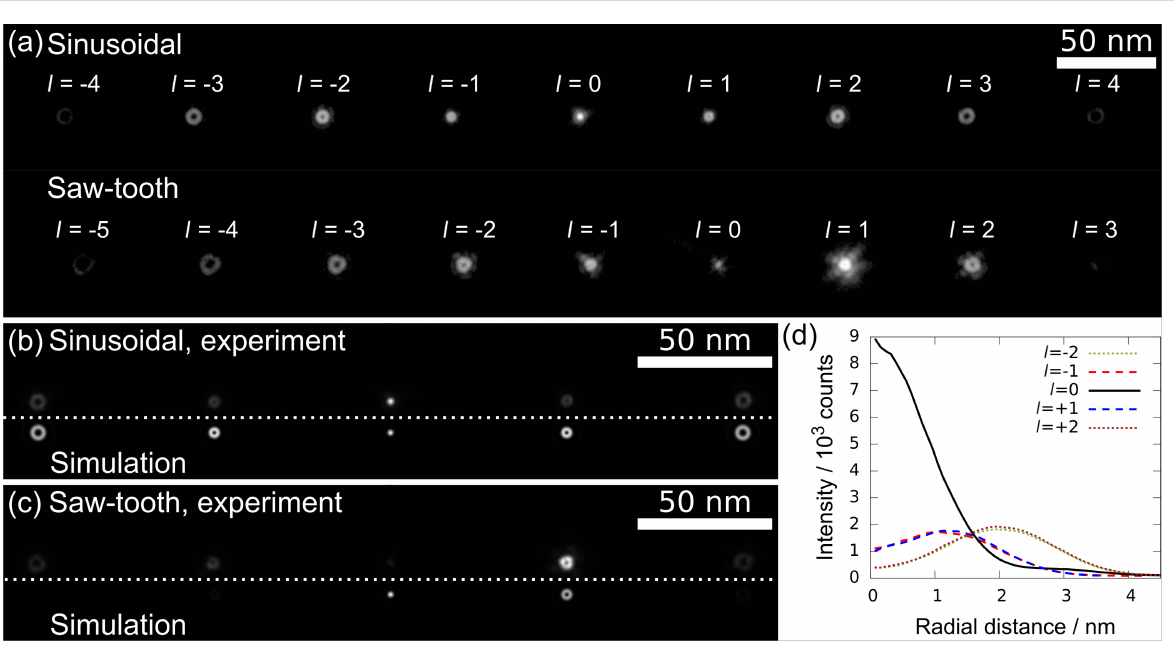
Figure 8: (a) Generated VBs in the object plane of a Philips CM200 for the sinusoidal and saw-tooth pattern, respectively. The images are displayed in logarithmic intensity scale to visualize multiple diffraction orders with strongly varying intensity. The size of the doughnut-shaped beam profile in- creases with the topological charge l . Magnified sections for l = − 2 to l = 2 for (b) sinusoidal and (c) saw-tooth patterns with linear intensity scale are compared with simulations. (b) The sinusoidal pattern shows good agreement, whereas for (c) a larger deviation is observed. (d) The azimuthally averaged intensities of the measured beams in (b) are plotted against the radial distance from the center of each